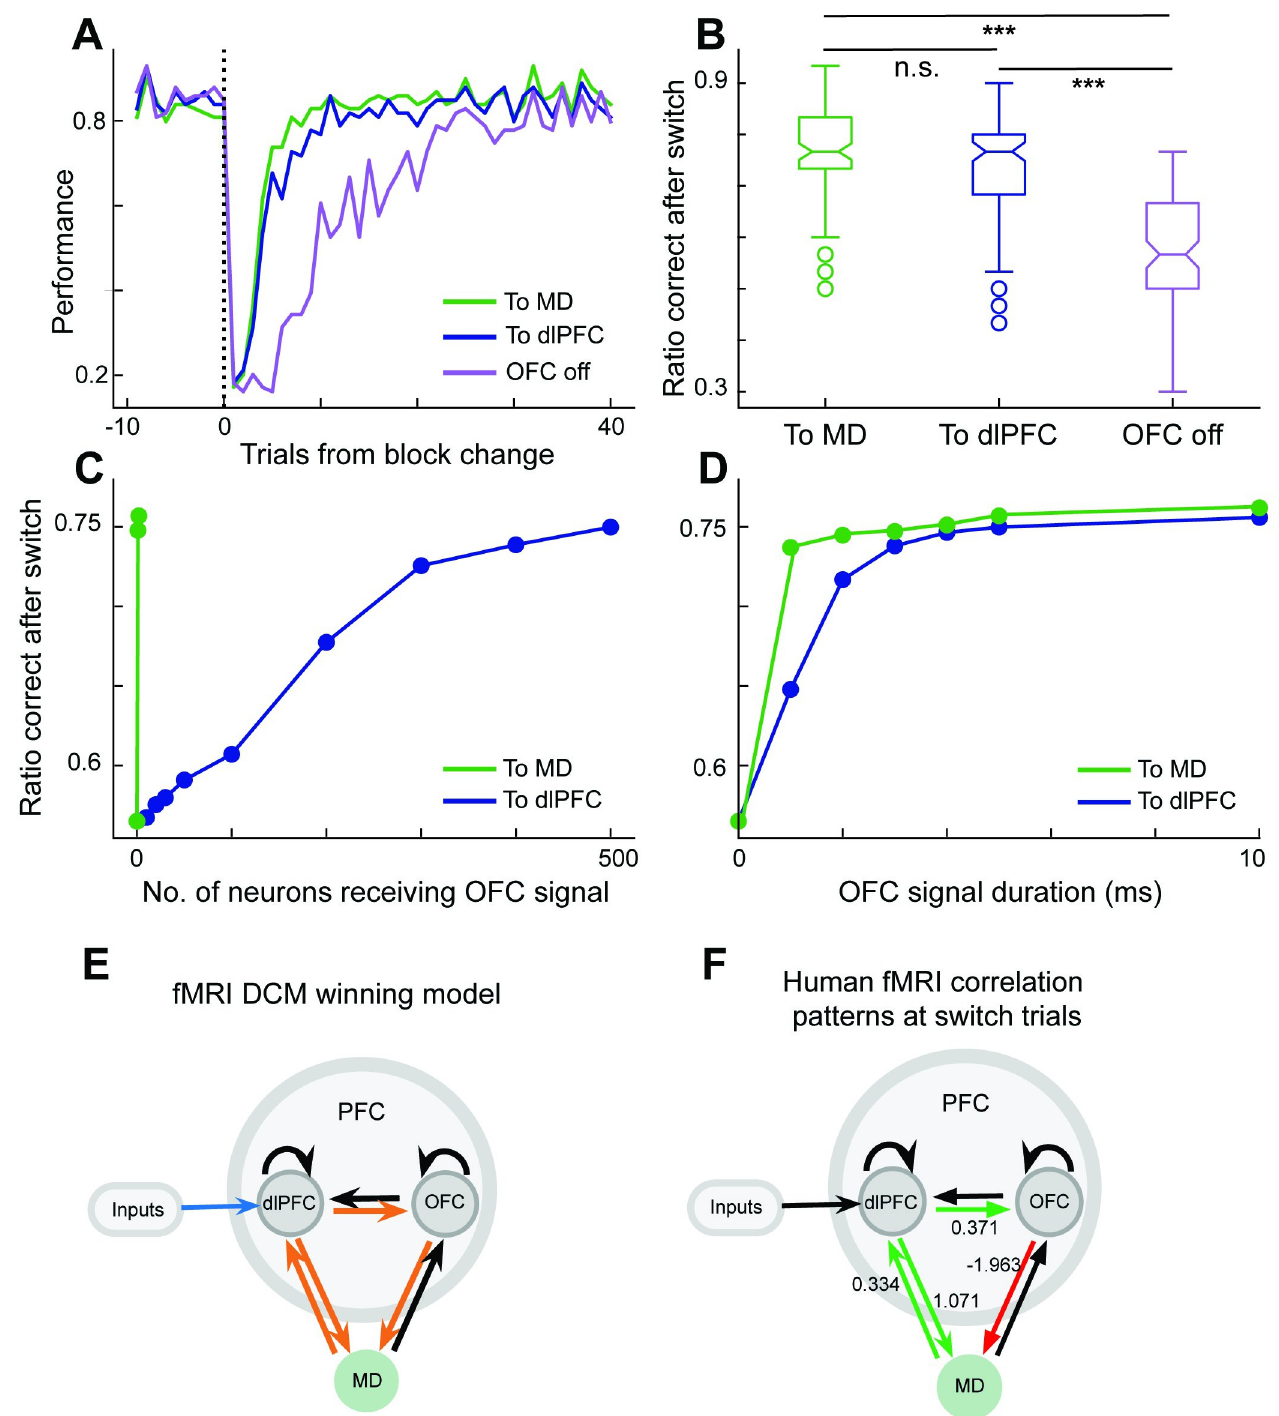
Fig 5. Human fMRI confirms computational advantage of transthalamic routing of cortical information suggested by neural model. We considered a Bayesian model capturing computations in the OFC that detected context changes and cued the dlPFC-MD neural model to switch behavioral strategy accordingly. Two nodes of the Bayesian model represented belief in current context (predominantly match or non-match context). Context nodes associated through Hebbian learning to neurons in MD or dlPFC that happened to be active. When the OFC model detected a switch, it activated the appropriate node for the inferred context, thereby activating dlPFC or MD neurons associated with it. A. The OFC switch signal enhanced performance immediately after a block change, and both sending the OFC signal to dlPFC or through a transthalamic route to MD performed comparably. B. Average performance in the 30